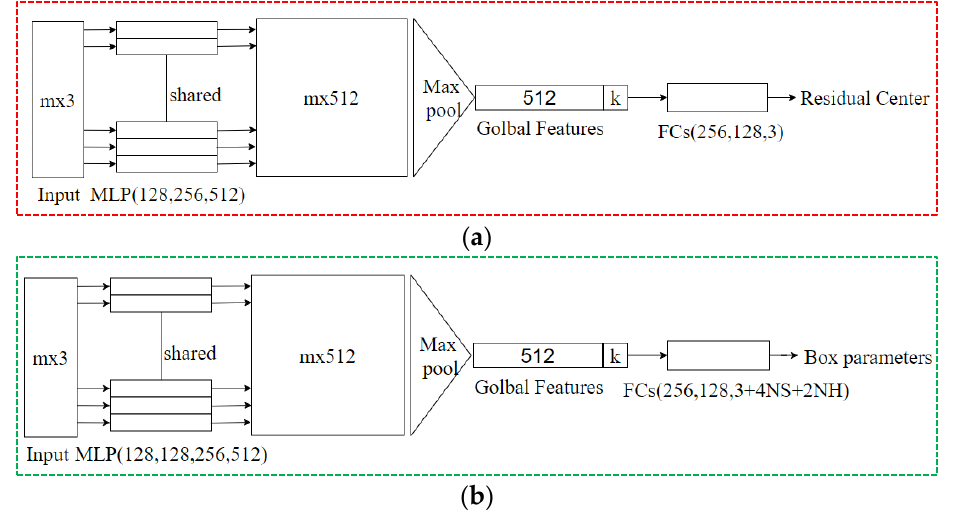
Figure 18. Localization Networks [24]: ( a ) T-net for estimating residual center; ( b ) Amodel 3D Box Estimation Net.